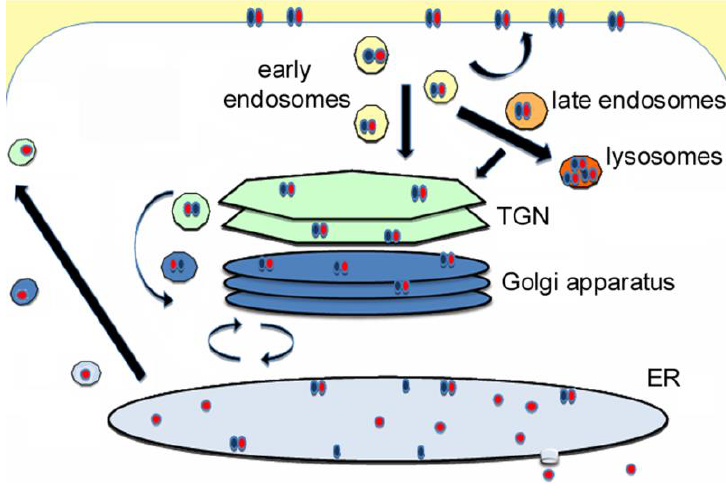
Figure 1. Intracellular toxin trafficking. The general trafficking and translocation itinerary for AB-type, endoplasmic reticulum (ER)-translocating toxins is shown. These toxins bind to distinct surface receptors and are internalized by a variety of endocytic mechanisms. The internalized toxin is recycled to the plasma membrane, directed to the lysosomes for degradation, or delivered to the trans-Golgi network (TGN) en route to the ER translocation site. Vesicle-mediated transport to the TGN can originate from the early or late endosomes, depending on which toxin is present. Likewise, multiple retrograde transport pathways can deliver the toxin from the TGN to the ER. The toxin may cycle between the Golgi and ER until the catalytic subunit dissociates from the rest of the toxin and shifts to an unfolded conformation which triggers its export to the cytosol in a process involving the quality control system of ER-associated degradation. Some of the free, ER-localized A chain escapes ER-associated degradation (ERAD) and is secreted back into the medium via Golgi and TGN intermediates. In most cell types, trafficking from the cell surface to the ER is very inefficient: the majority of internalized toxin is routed to the lysosomes, and only around 10% of surface-bound toxin reaches the ER [9–16]. Thus, ectopic expression of an ER-localized A chain via transfected cultured cells, transformed yeast, or microsomal transcription/translation systems is often used for toxin translocation